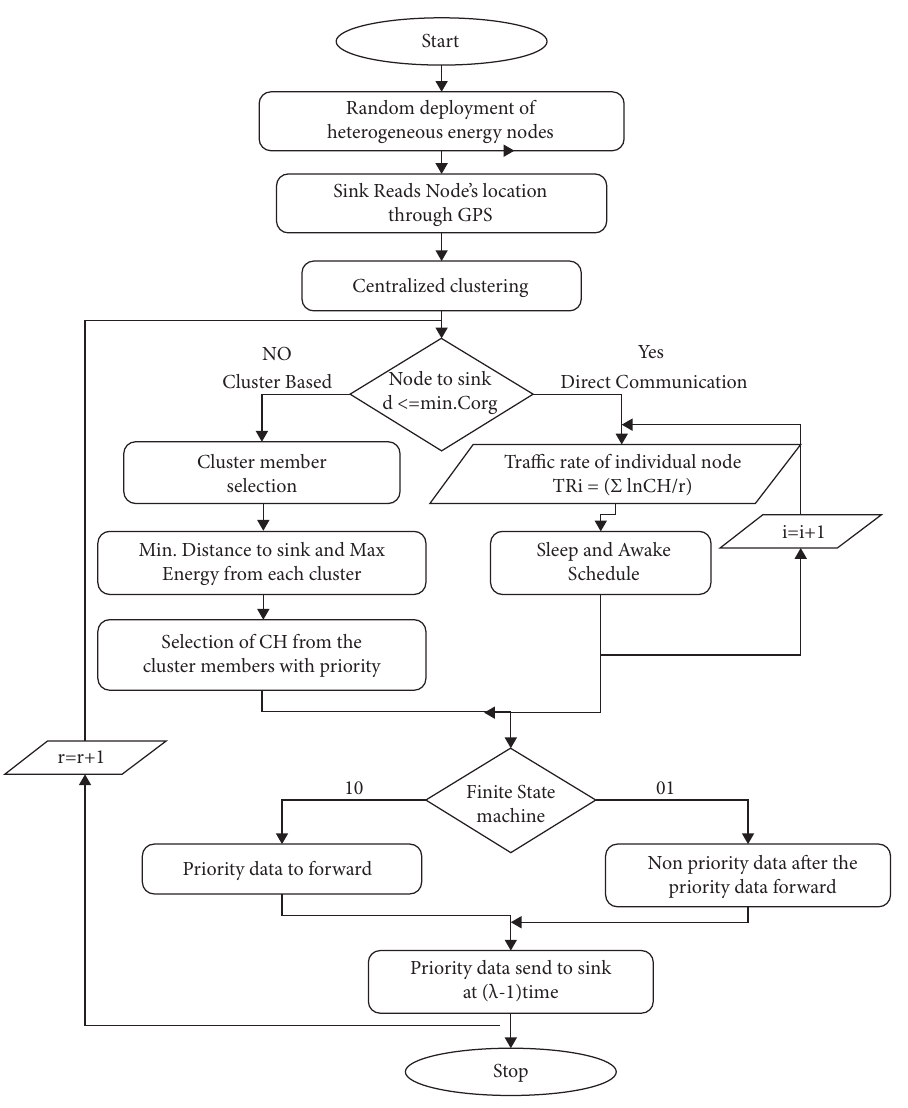
Figure 1: Flow diagram of HETA